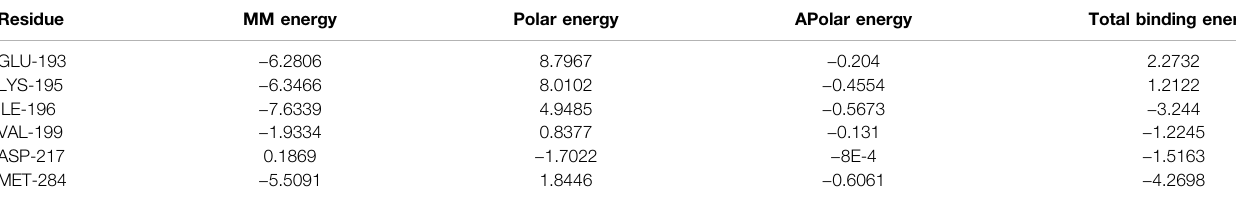
TABLE 2 | Energy contribution of the amino acid residues in kaempferol-NF- κ B p65 complex (kcal/mol).